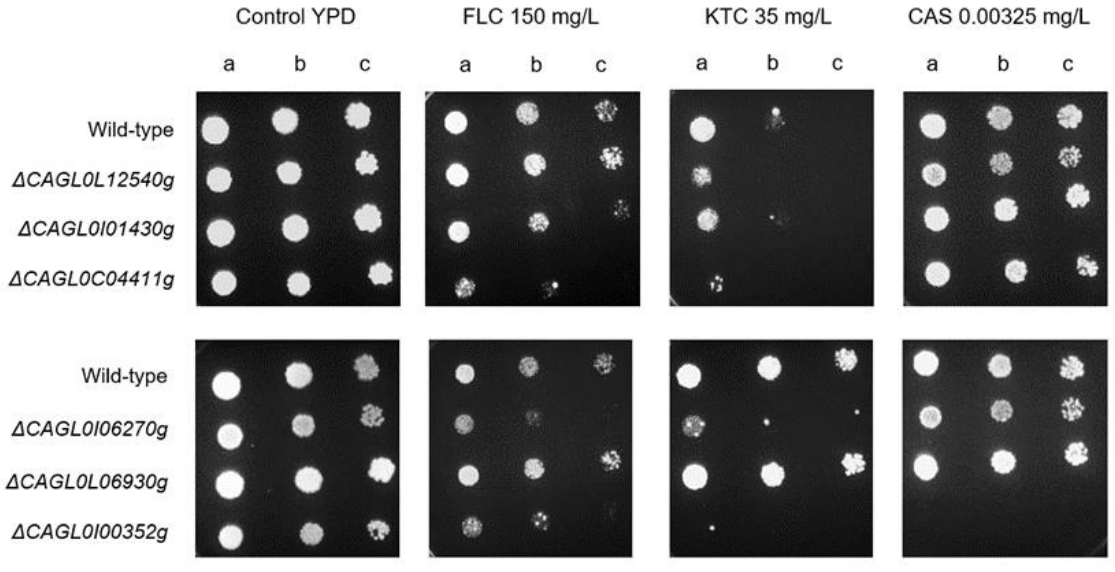
FIGURE 5: Comparison of the susceptibility to antifungal azole drugs and caspofungin, at the indicated concentrations, of the C. glabrata KEU100 wild-type strain or derived single mutant strains on YPD agar plates by spot assays. The inoculum was prepared as described in the Materials and methods section. Cell suspensions used to prepare the spots correspond to 1:5 (b) and 1:25 (c) dilutions of the cell sus- pensions used in (a). The displayed images are representative of at least three independent experiments.